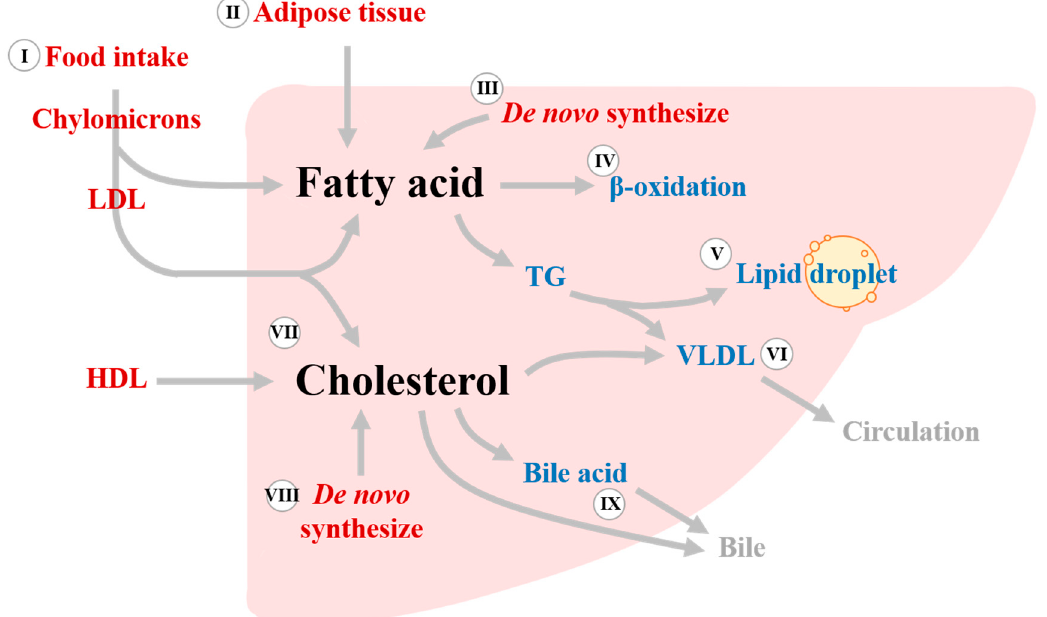
Figure 1. Lipid metabolism in the liver. The liver is the main site of fatty acid and cholesterol metabolism. Fatty acids come from three main sources: food intake (I), adipose tissue lipolysis (II), and de novo lipogenesis (III). Fatty acids are then used for the production of energy via β -oxidation (IV), synthesis of TGs and storage in lipid droplets (V), or packing into VLDLs and secretion into the circulation (VI). Hepatic cholesterol comes from circulating lipoproteins (LDL and HDL, VII) or de novo synthesis in the liver (VIII). Cholesterol is subsequently used as a component of the plasma membrane of hepatocytes, packaged into VLDLs and released as a cholesterol source for extrahepatic organs (VI), or directly released or converted to bile acid and released into the bile duct (IX). TG, triglyceride; VLDL, very low-density lipoprotein; LDL, low-density lipoprotein; and HDL, high-density lipoprotein.